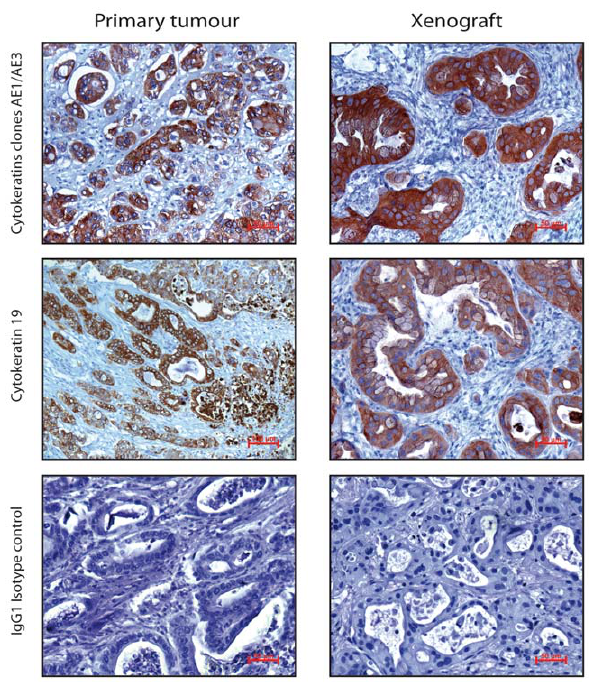
Figure 7. Immunohistochemistry of cytokeratins. Immunohisto- chemistry was performed on primary and xenograft tumour slices. Cytokeratins AE1/AE3 and more specifically cytokeratin 19 were expressed in ductal structures of primary and xenograft tumours (brown). Isotype controls were negative.